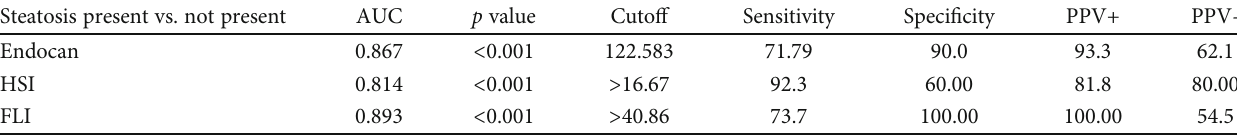
Table 3: ROC analysis and diagnostic screening tests were used to determine the cuto ff point for endocan, HSI, and FLI. Steatosis present vs. not present